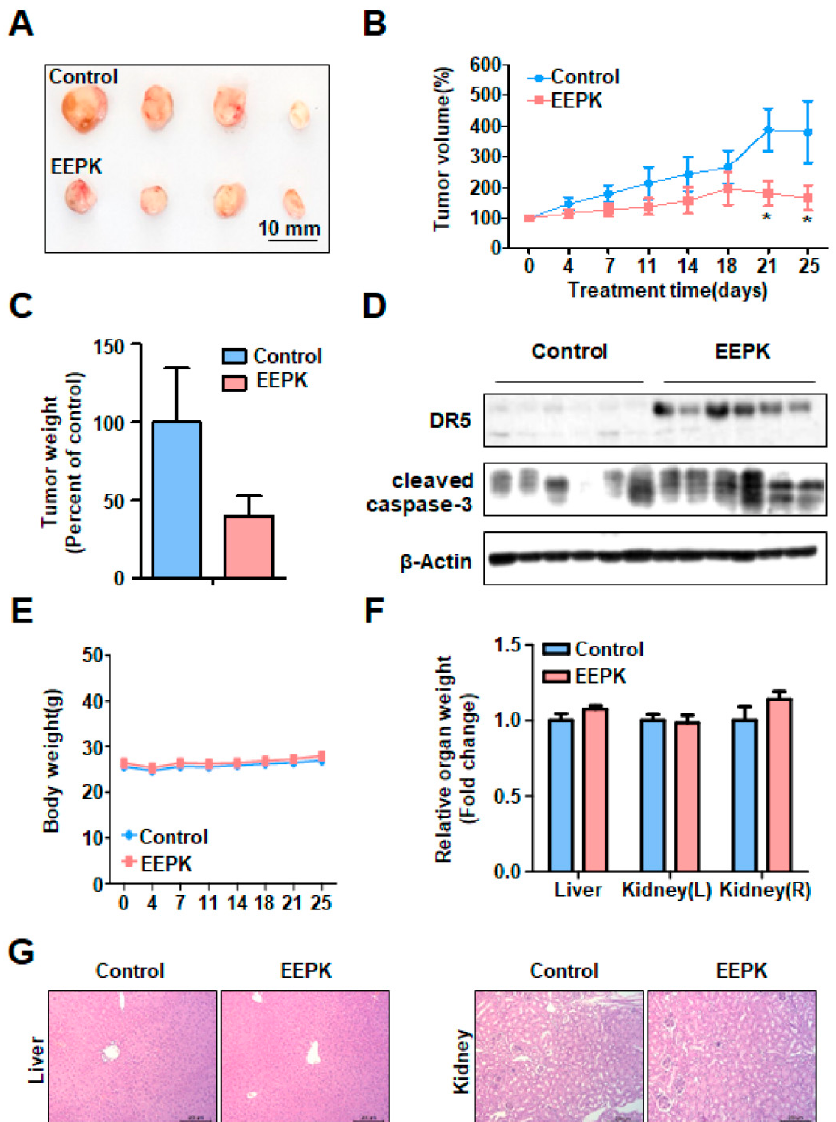
Figure 5. Effects of EEPK on tumor growth in a nude mouse xenograft model bearing HN22 cells. HN22 cells was inoculated with subcutaneous injection into the flanks of the mice, and mice were then received 2.5mg/kg/day of EEPK (i.p) five times per week for 25 day ( n = 6 per group). ( A ) Representative images of tumors of mice after sacrificed. Tumor volume ( B ), tumor weight ( C ), of vehicle control or EEPK-treated groups were monitored as described in Materials and methods. Graphs represent mean ± SD and significance ( p < 0.05) compared to the vehicle control group is indicated (*). ( D ) Expression level of DR5 and cleaved caspase-3 detected by Western blotting. ( E ) Body weight were measured as described in Materials and methods. ( F ) Liver and kidney were surgically removed, and their weights were measured. Data are presented as the mean± S.E. ( G ) Histopathological changes of liver and kidney were visualized by H&E staining. Representative images are shown (magnification, X100).